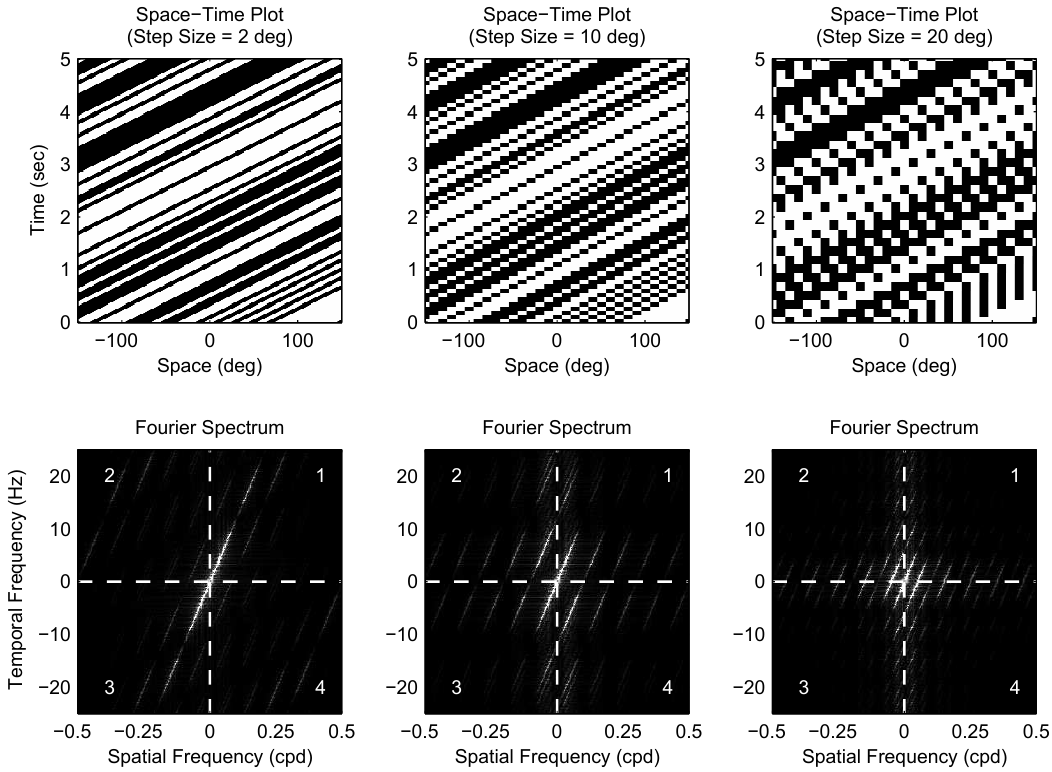
Figure 2. Spacetime plots and Fourier spectra for stimuli with different step sizes (10 deg elements). The top panels show space–time plots and the bottom panels show corresponding spatiotemporal Fourier spectra for a number of step sizes (the element size is 10 deg in all plots). When the step size is much less than the element size (left column), the stimulus is perceived by humans as moving smoothly and its motion energy is situated in quadrants 1 and 3 in the Fourier spectra (i.e., motion in the rightwards direction). In the middle column (step size equals element size), humans see the stimulus as moving less smoothly and part of its motion energy is now distributed in quadrants 2 and 4 in the Fourier domain (leftward motion). Finally, when the step size is much larger than the element size (right column), motion energy is more evenly distributed across the four Fourier quadrants, and humans find it significantly more difficult to identify the motion